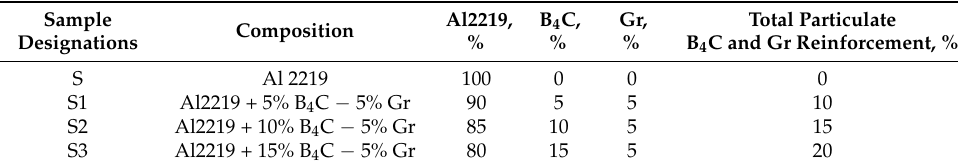
Table 2. Percentage of particulate reinforcement by weight